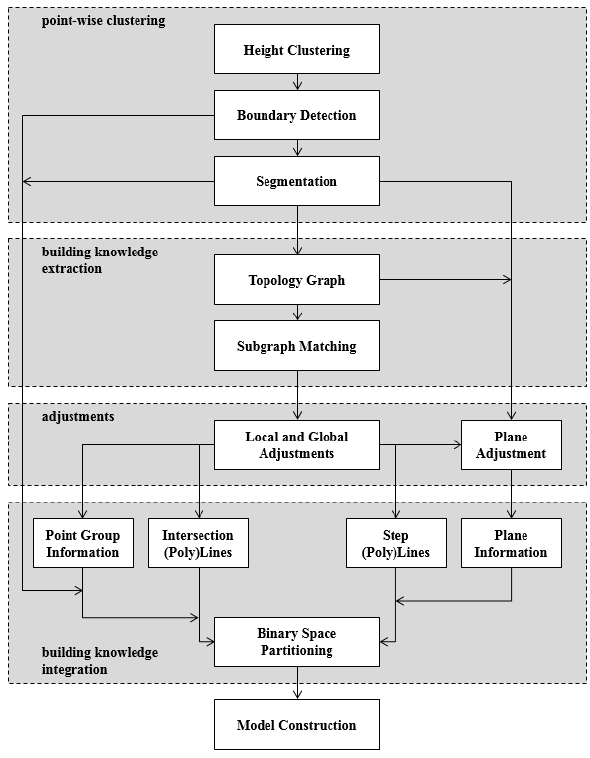
Figure 3. Overview of the extended BSP based reconstruction approach which integrates building knowledge for the construction of regularized